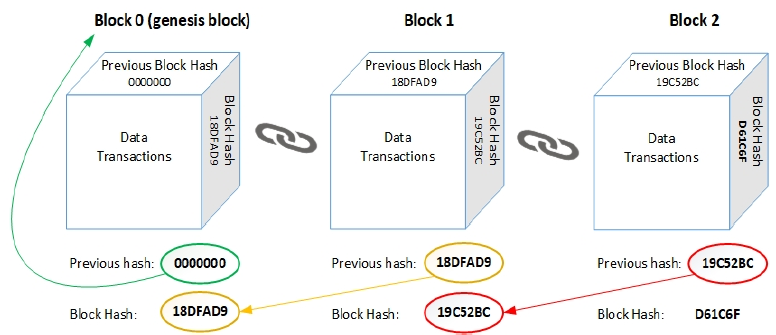
Figure 1. Blockchain data model.